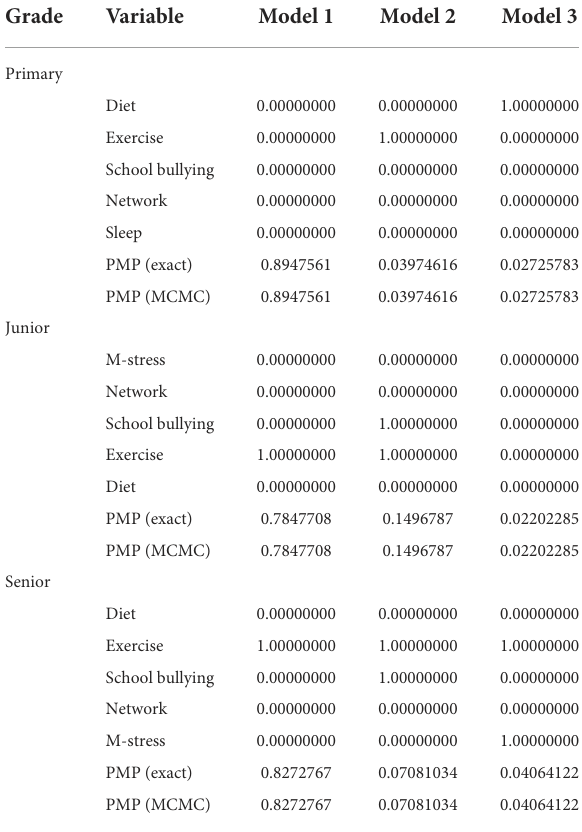
TABLE 4 Model post probabilities for each